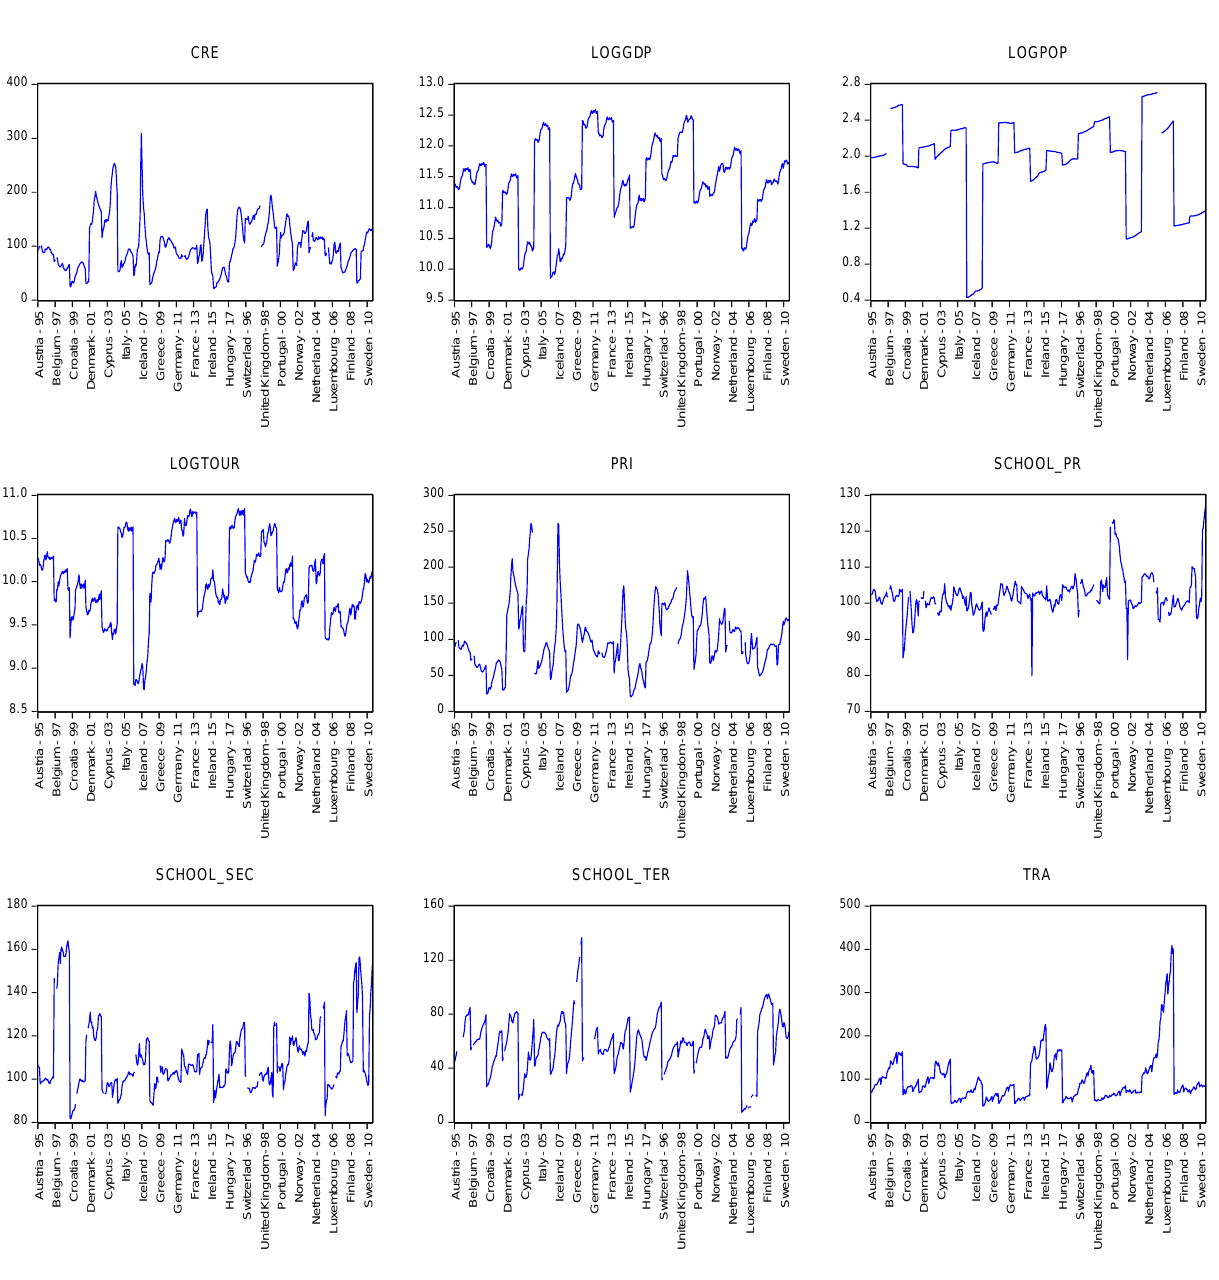
Figure 1. Evolution of sample variables.